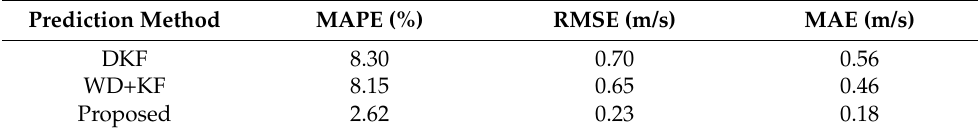
Figure 17. PDF and CDF of the prediction error using the proposed method. Table 1. Forecast results of the three methods.